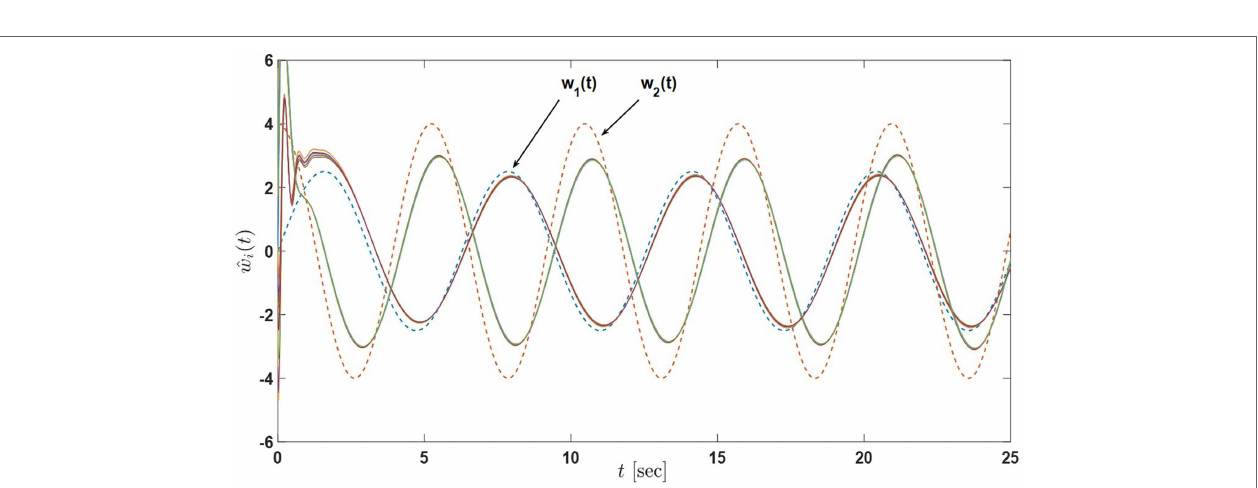
FIGURE 11 | Input estimates of the sensor network in Example 3 with 12 active nodes under the proposed architecture equations (7) and (8) (the dash lines denote the inputs of the actual process and the solid lines denote the input estimates of nodes) Tran et al. (2017).